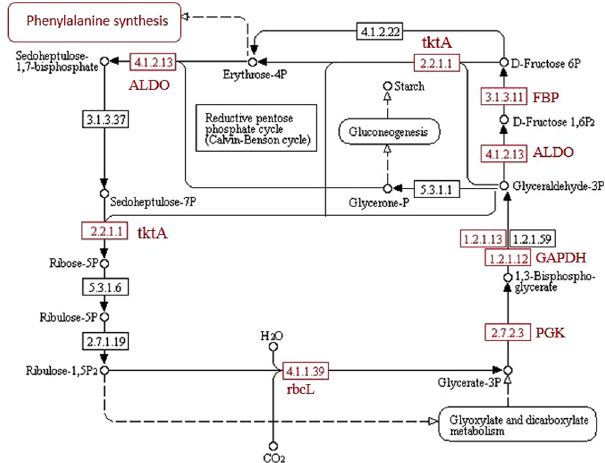
Figure 6. Main protein changes relating to carbon fixation in photosynthetic